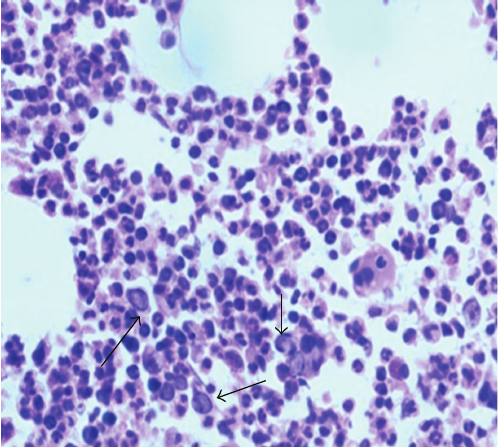
Figure 2: Bone marrow biopsy showing giant proerythroblast, nuclear clearing with eosinophilic intranuclear inclusion and peripheral condensation of chromatin. Late erythroid precursors are reduced, and myeloid cells are increased.